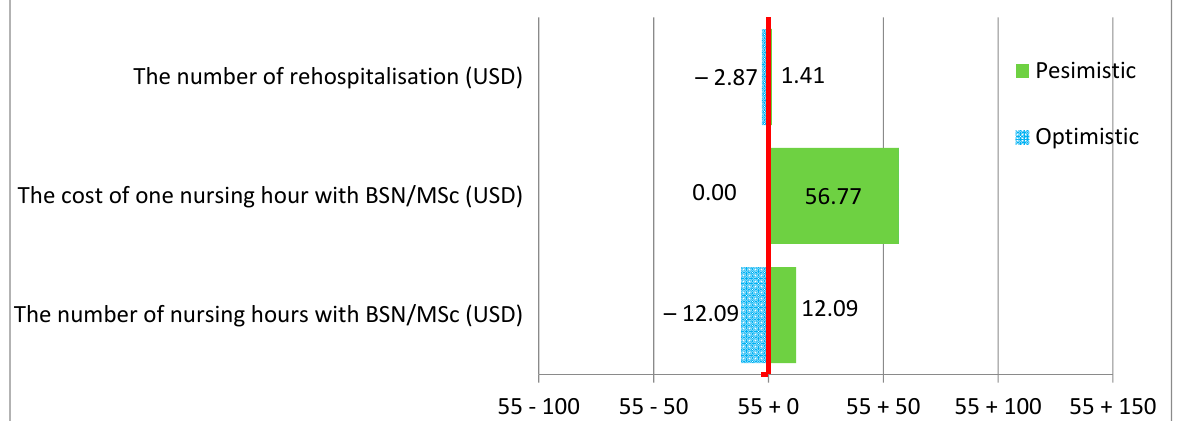
Figure 2. Increasing the percentage of care provided by nurses with BSN/MSc degrees by 10% in non-surgical wards.